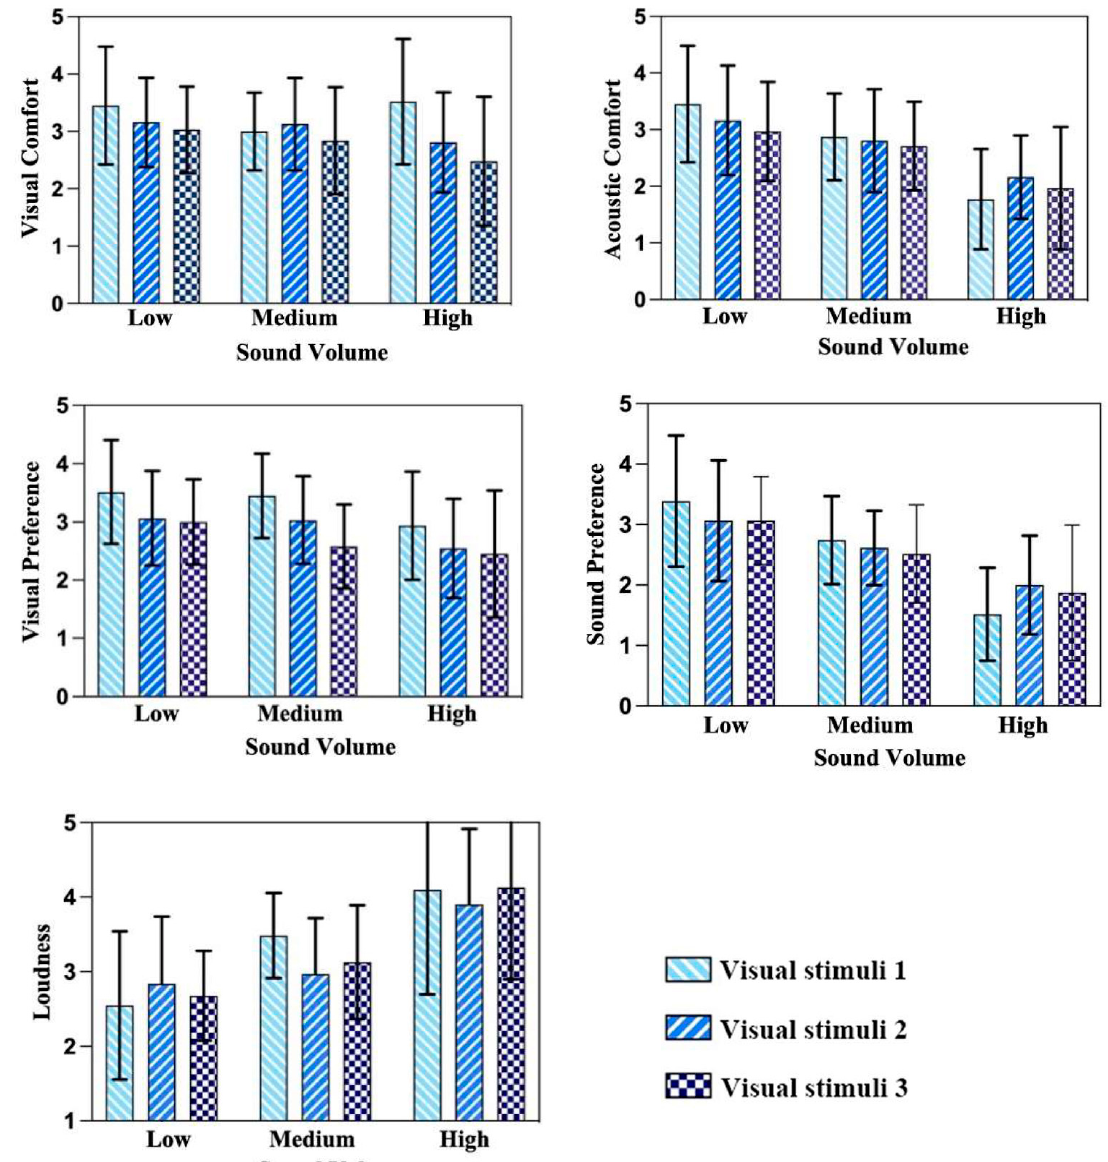
Figure 5. The mean ratings of evaluation indicators under the effect of visual crowd density. Table 3. The evaluation under the effect of sound and visual stimuli .